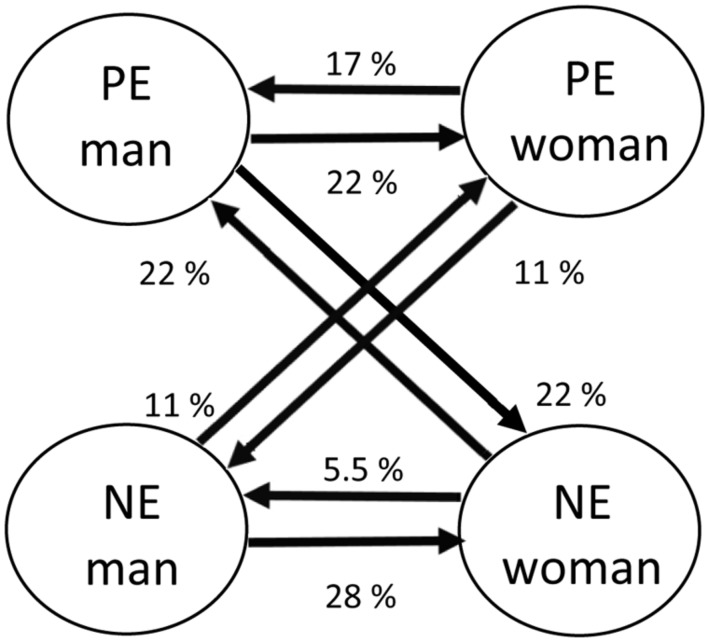
Percentages of interdependent couples that evidenced specific cross-partner connections.